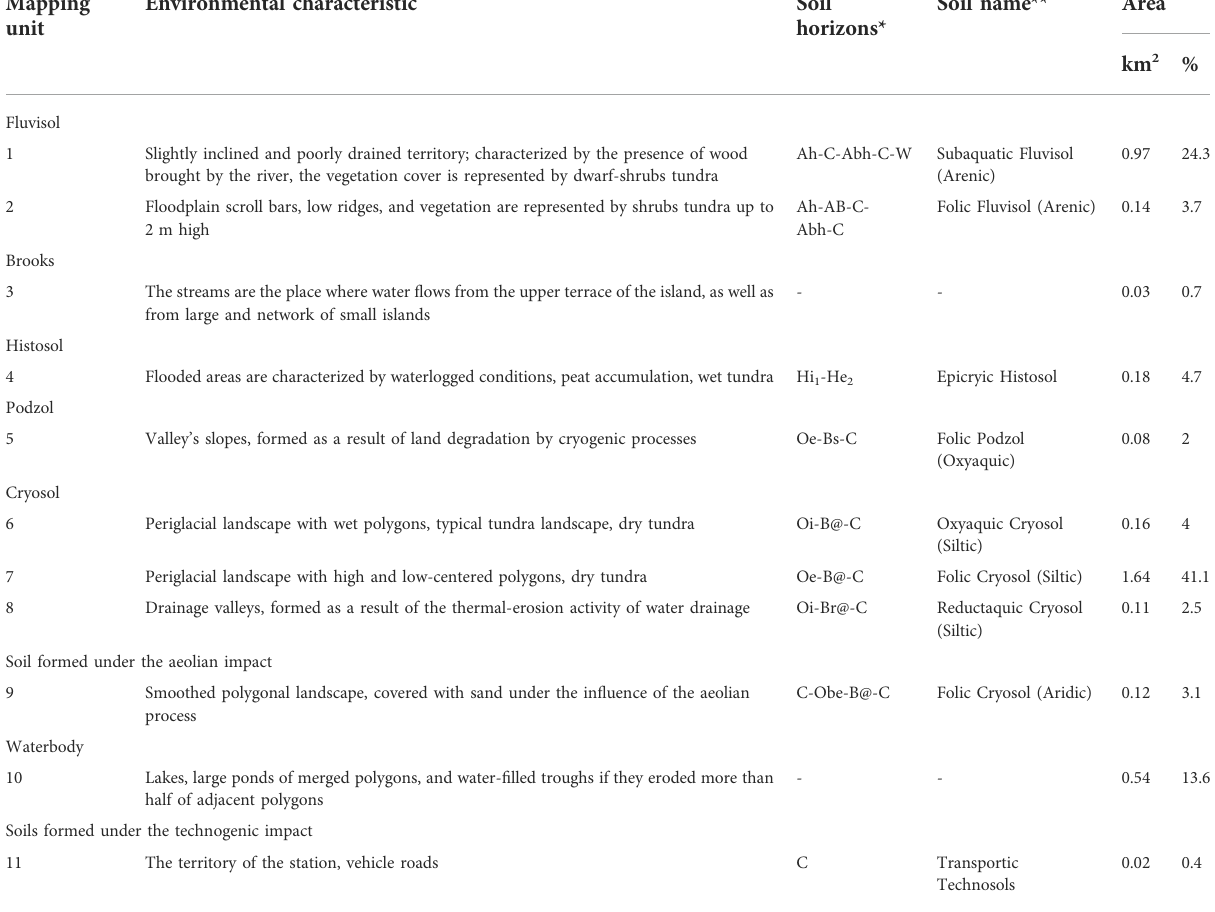
TABLE 1 Legend for the soil-geomorphological map of the Samoylov isl., Lena River Delta. Mapping